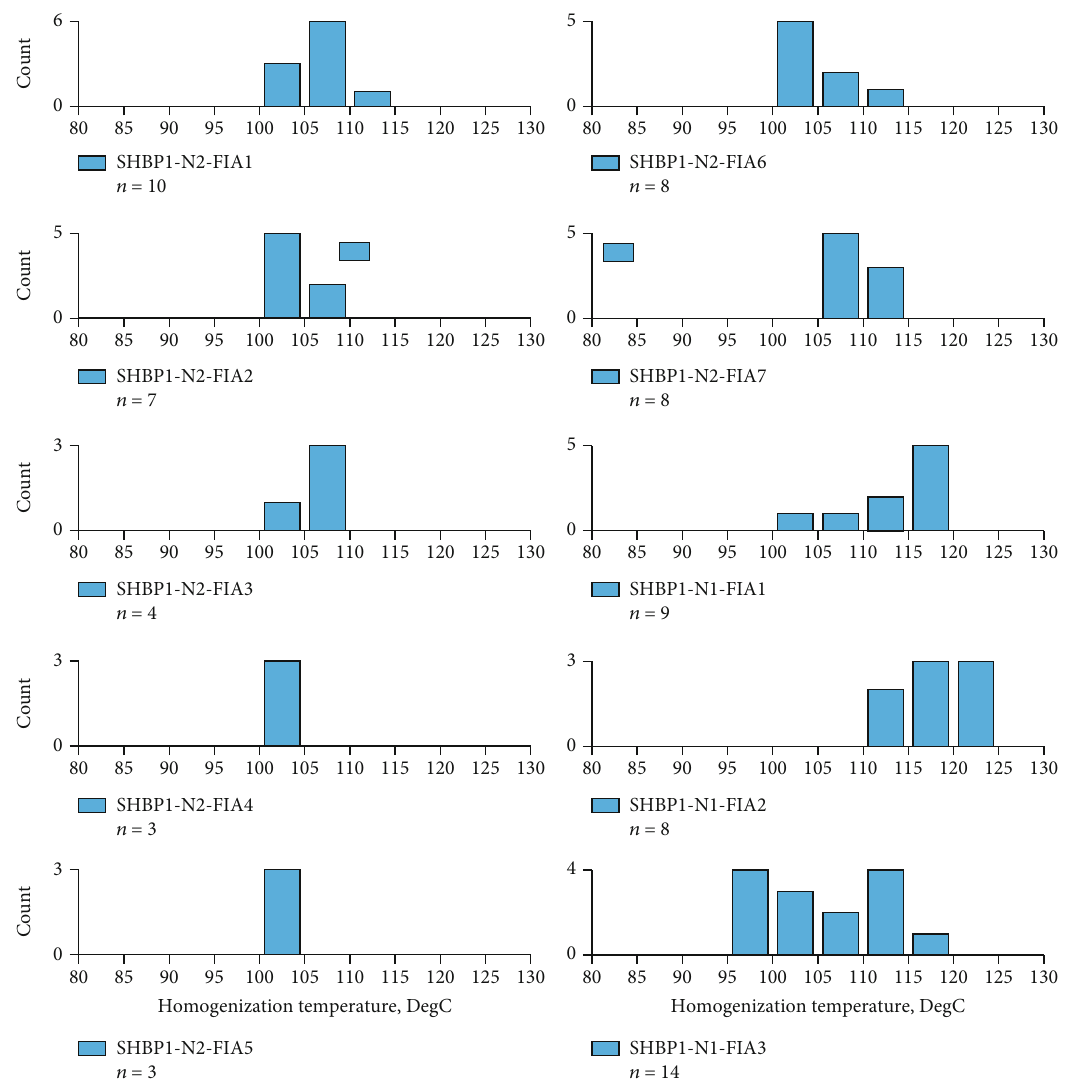
Figure 8: Histograms of homogenization temperatures of fl uid inclusions in each FIA in